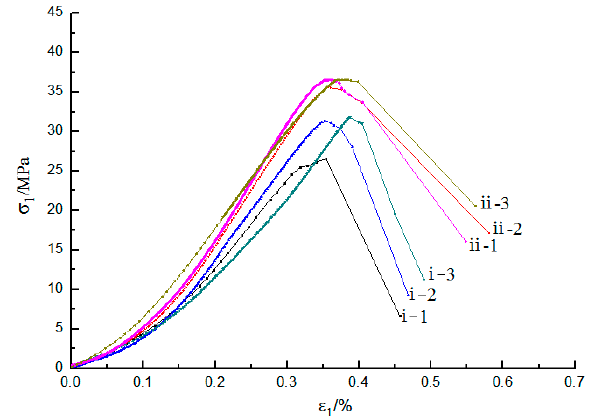
Figure 6. Stress–strain curves of coal specimens under uniaxial compression. Table 1. Rock mechanical test results.